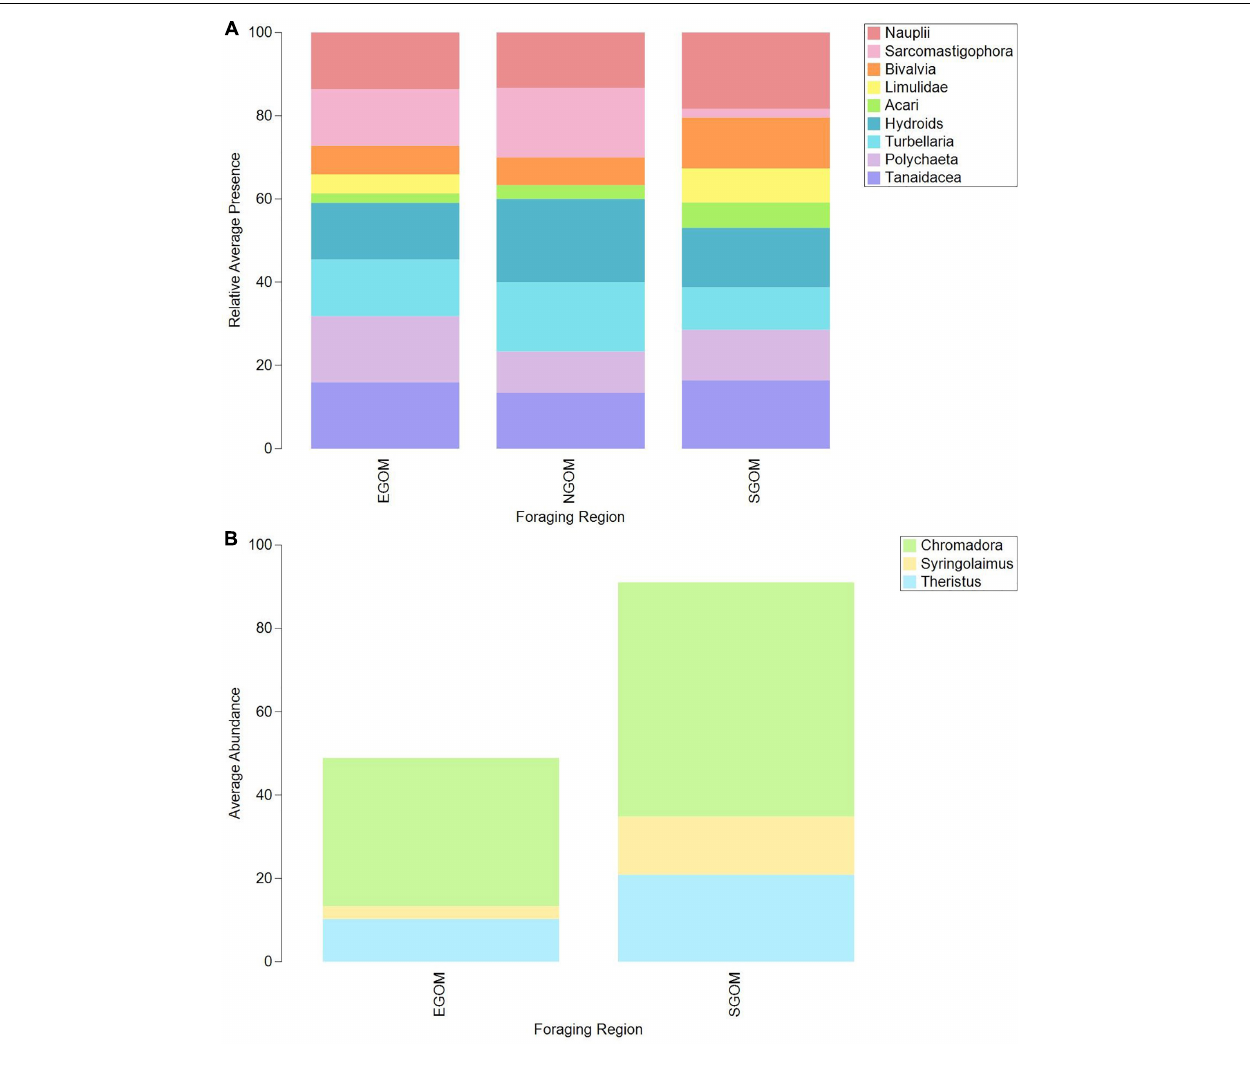
FIGURE 3 | Bar plots of average relative presence of (A) meiofauna and (B) nematode taxa contributing to dissimilarities between Eastern Gulf of Mexico (EGOM), Southern Gulf of Mexico (SGOM), and Northern Gulf of Mexico (NGOM) DF-assigned turtles, identified via SIMPER. See Supplementary Tables 1, 2 for specific taxa contributions to dissimilarities between groups (full SIMPER